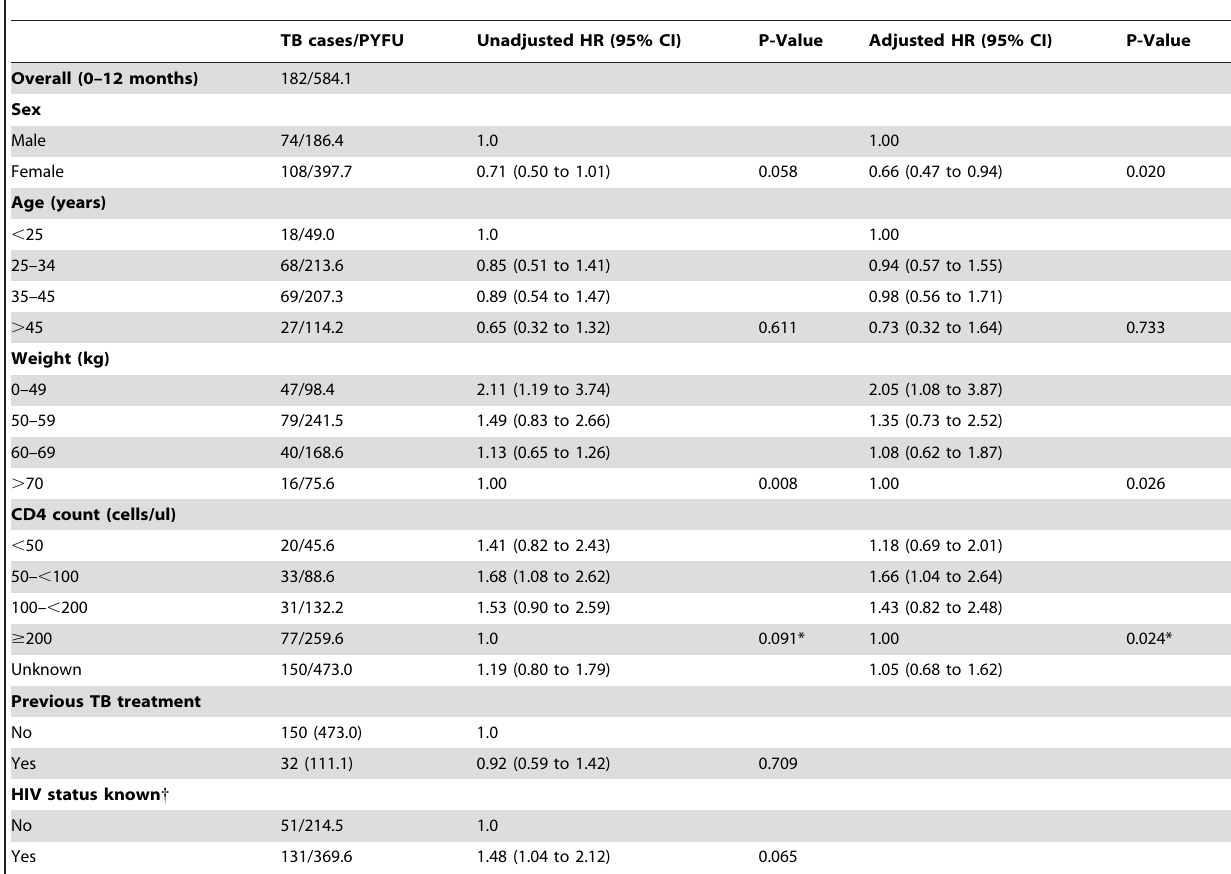
Table 3. Univariable and multivariable analysis of risk factors associated with TB diagnosis in HIV-positive